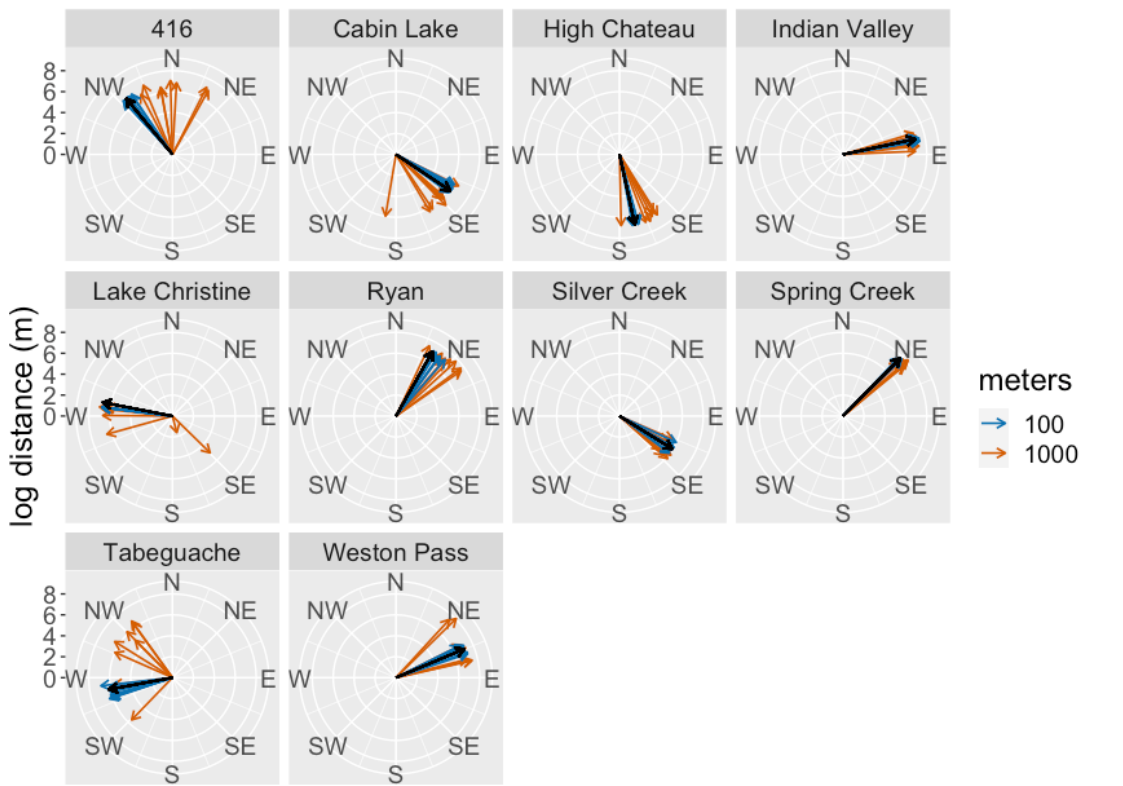
Figure 8. Forecast direction of propagation for case studies initiated at the time of detection. The range of propagation directions tends to be wider for simulations initiated 1000 m away (orange vectors) from the detection location than for those initiated 100 m away (blue vectors) from the detection location. he direction of the simulation initiated from the detection location is shown in